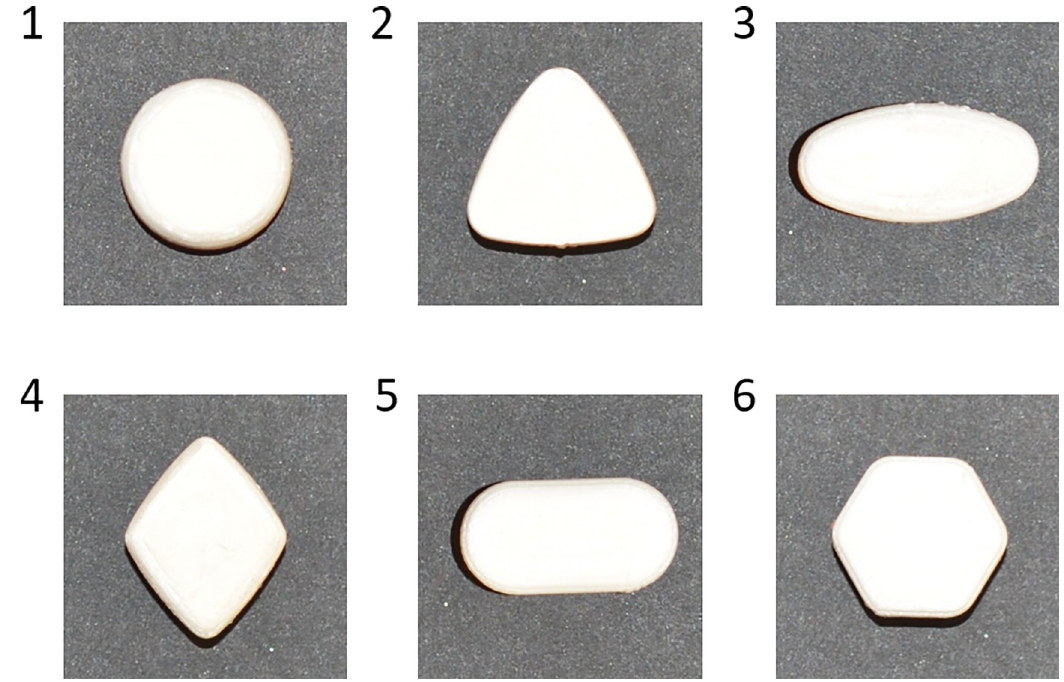
Fig 5. 3D printed angular vs. curved pills’ stimuli used in Study